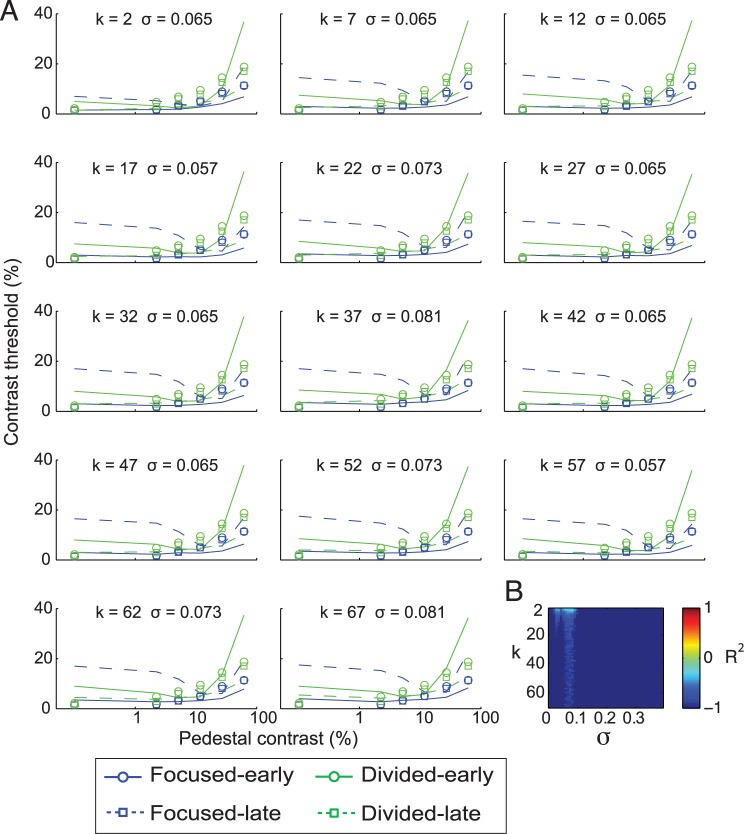
Linking changes in the psychophysical data and the P1 data using the efficient readout model.(A) The psychophysical contrast-discrimination thresholds estimated from the P1 data using the max-pooling rule (Eq 11) with different k values and with the noise values that yielded the best fits for those k values. (B) Corresponding R2 values. Overall, the efficient readout model did not effectively capture the link between behavior and the P1 responses in this data set, as R2 values are below 0 for all k and noise values. Negative values of the goodness of fit (R2) metric indicate that fits are worse than a horizontal fit line. Data are available from the Open Science Framework (https://osf.io/pc7dr/).